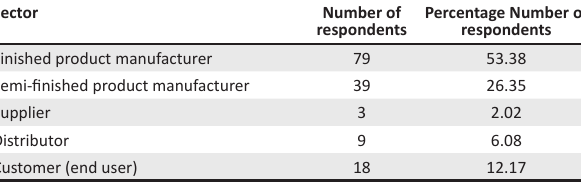
TABLE 2: Respondents’ value chain sector.